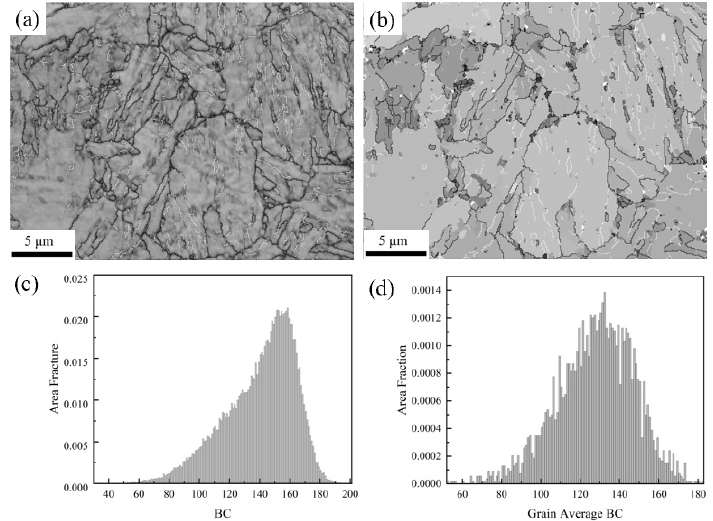
Figure 5. EBSD analysis for phase determination: ( a ) original BC map; ( b ) grain average BC map; ( c ) original BC profile; and ( d ) grain average BC